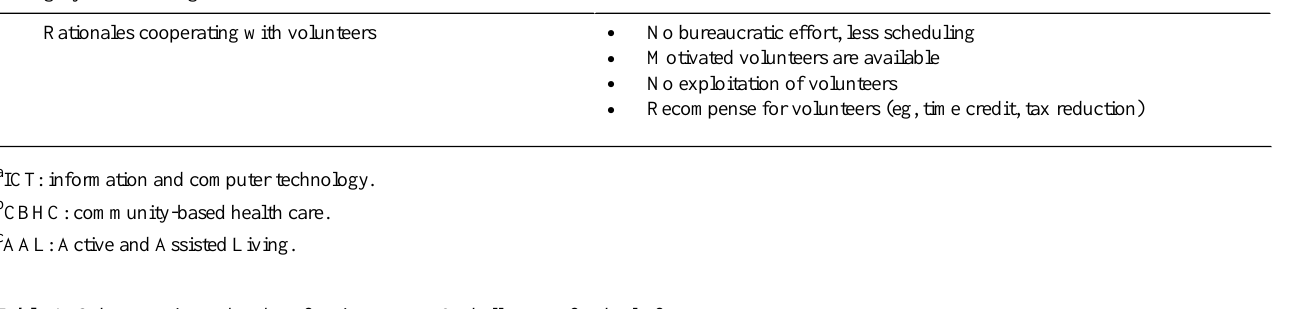
Table 4. Subcategories and codes of main category 2: challenges of web platform